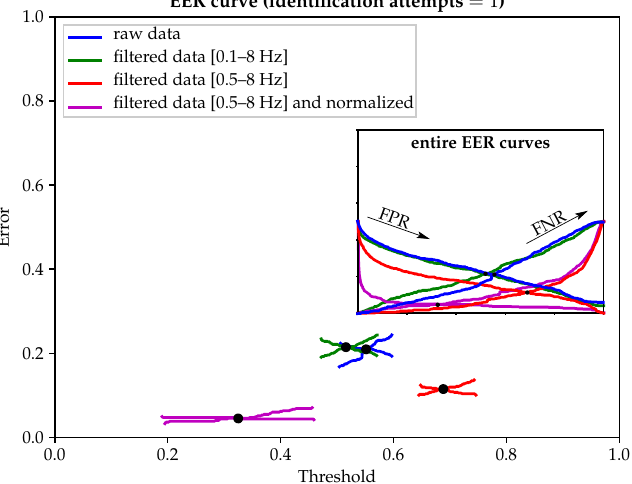
Figure 5. Minimum equal error rate (EER) for different input PPG signal preprocessing modalities. The inset shows the entire EER curves as well as FPR (false positive rate) and FNR (false negative rate) trends for different threshold